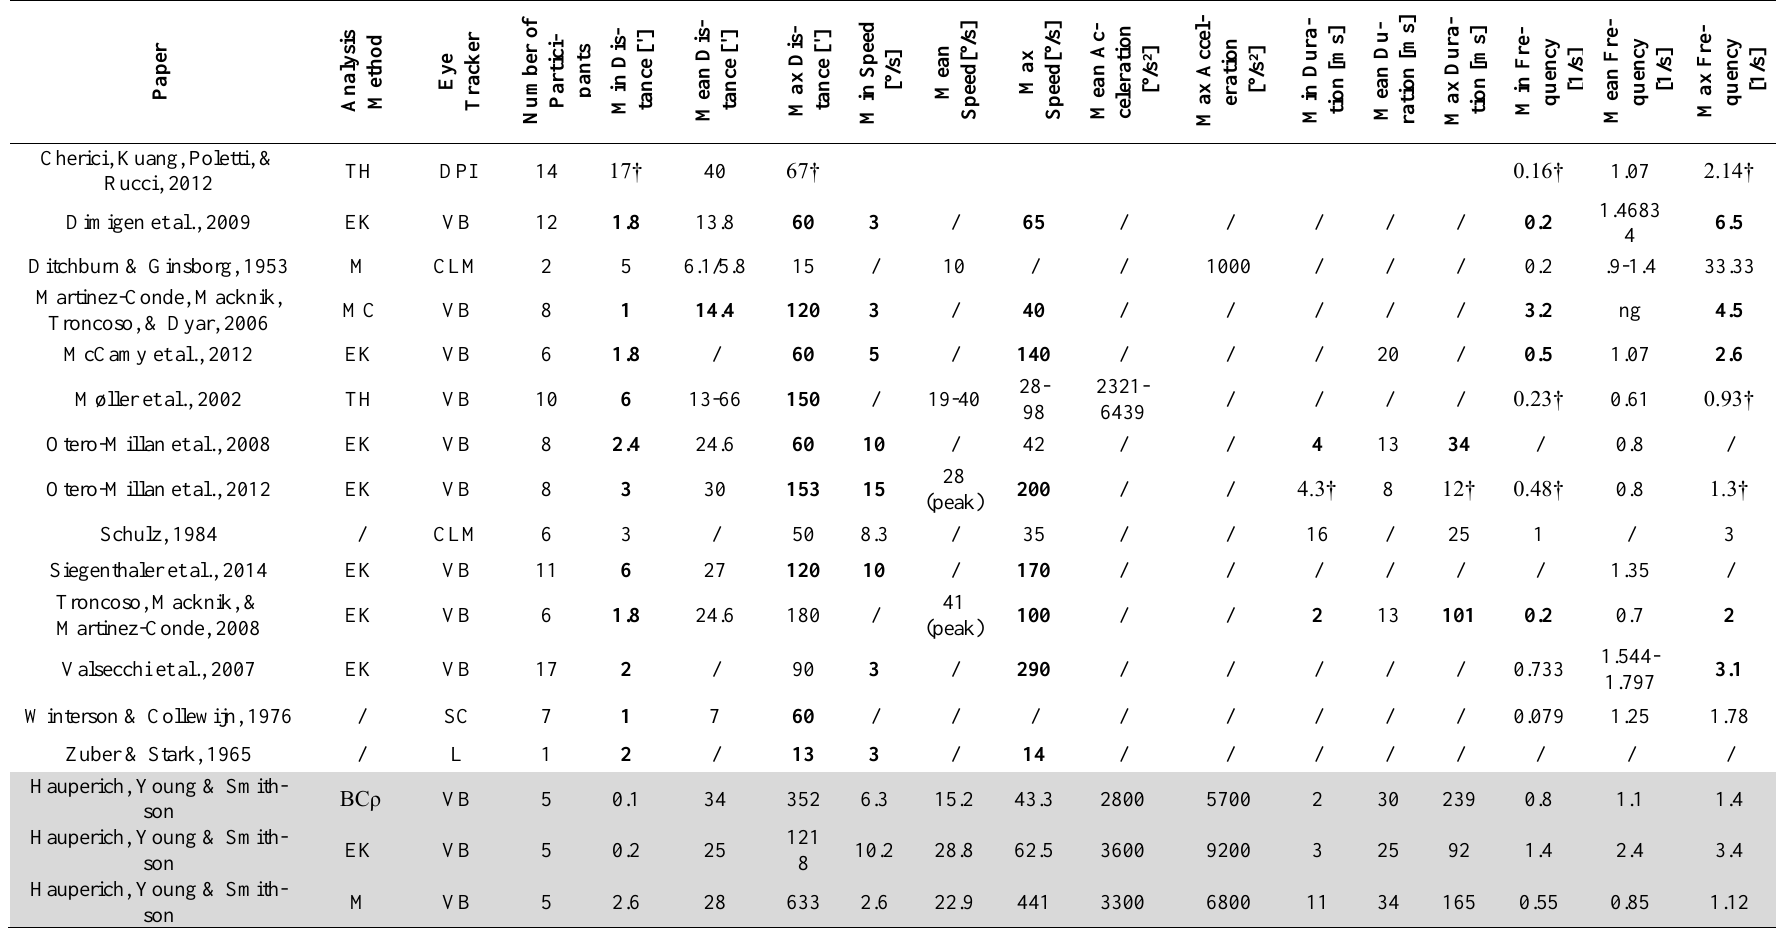
Table 1. Selected data from the literature review on microsaccades. For the full table please refer to the supplementary methods.